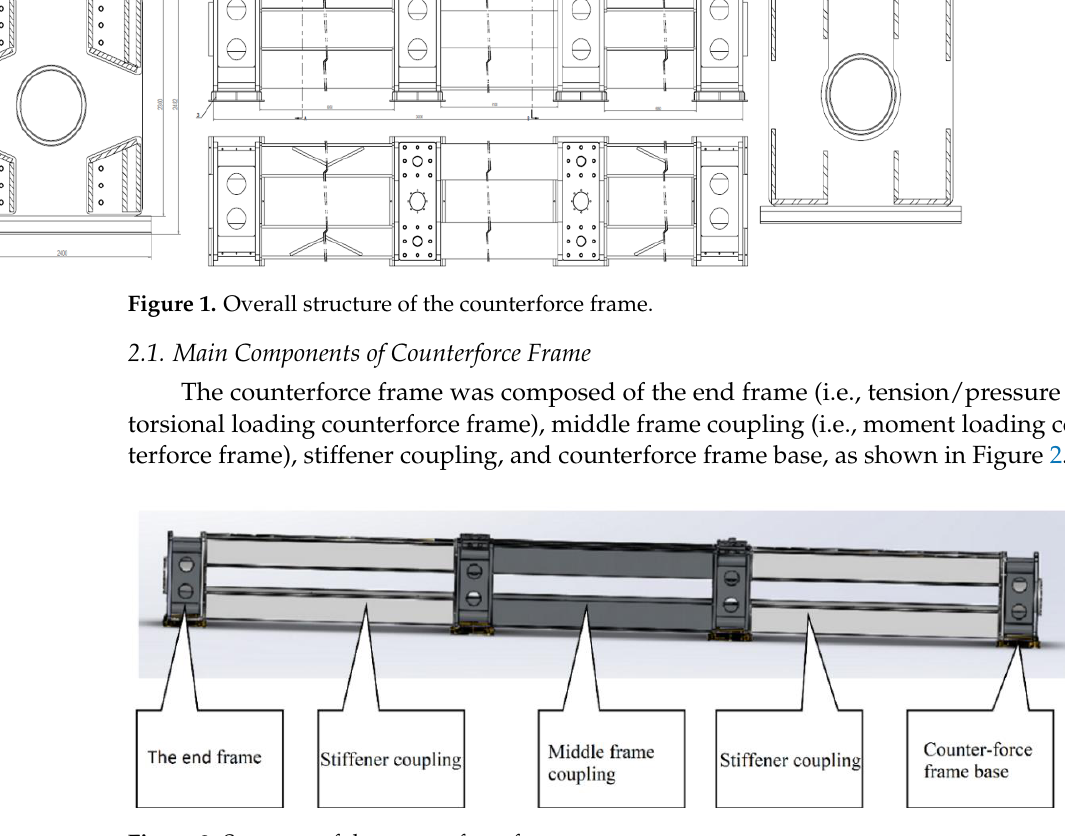
Figure 2. Structure of the counterforce frame.